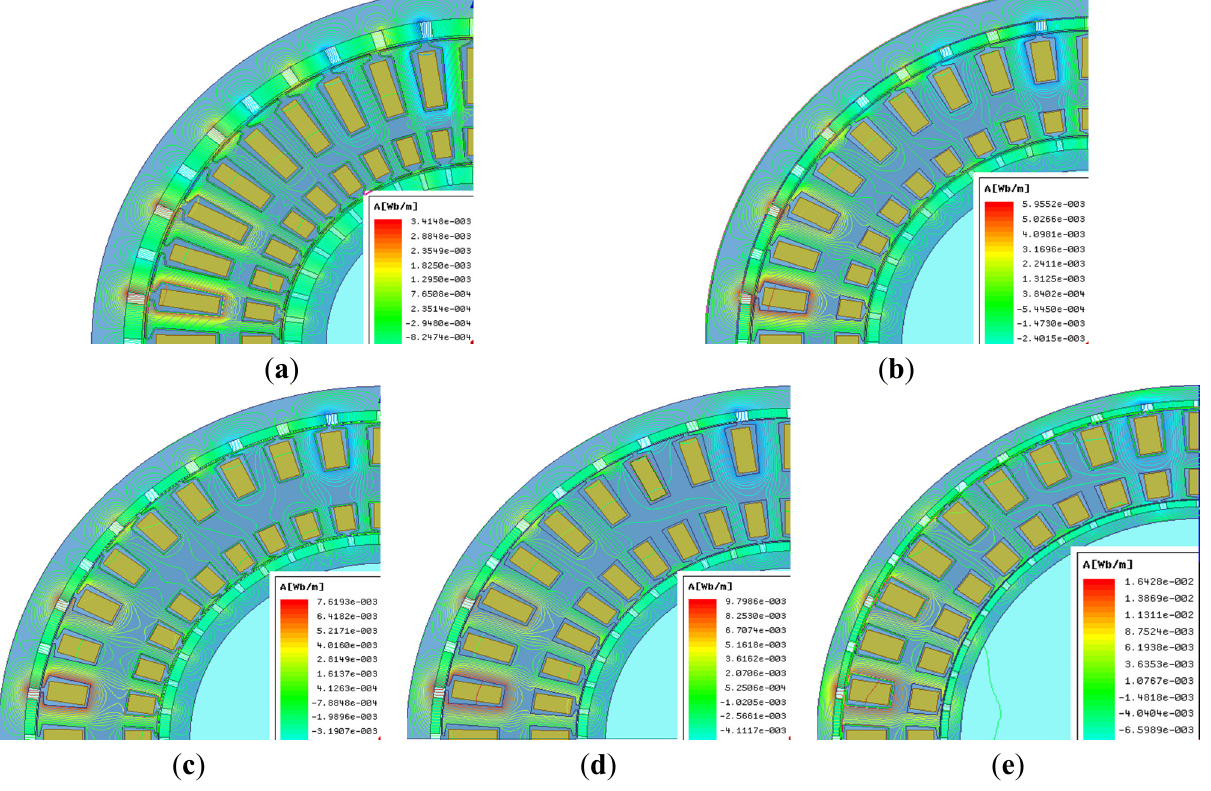
Figure 6. The flux lines distribution of ( a ) 1 kW; ( b ) 5 kW; ( c ) 10 kW; ( d ) 20 kW; and ( e ) 70